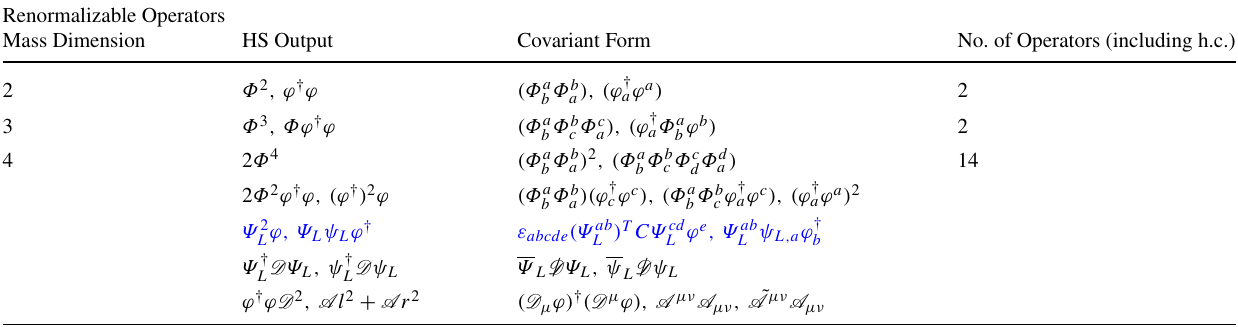
Table 50 Georgi-Glashow Model: Operators that comprise the renor- malizable Lagrangian (for N f = 1). The operators in blue have distinct hermitian conjugates which we have not written explicitly. Here, a , b , c